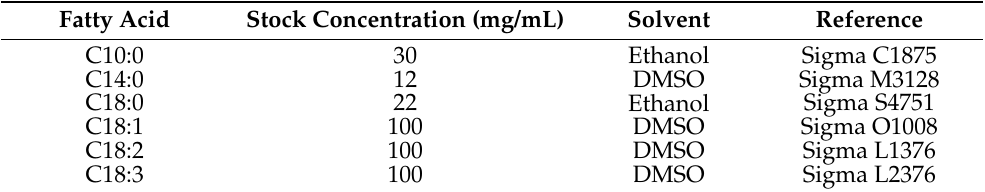
Table 1. Free fatty acids were purchased from Sigma and resuspended at the following concentrations either in ethanol or DMSO.